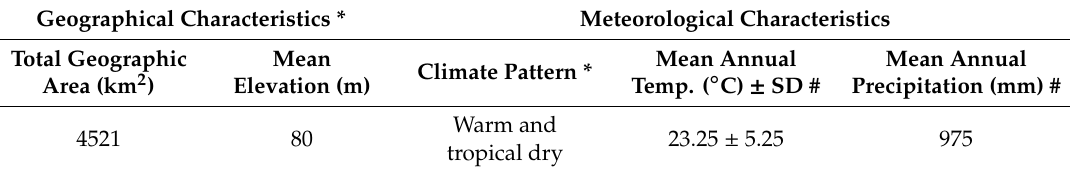
Figure 2. Geographical location of the study area. Table 2. Geographical and meteorological characteristics of the area studied (Mirzapur).